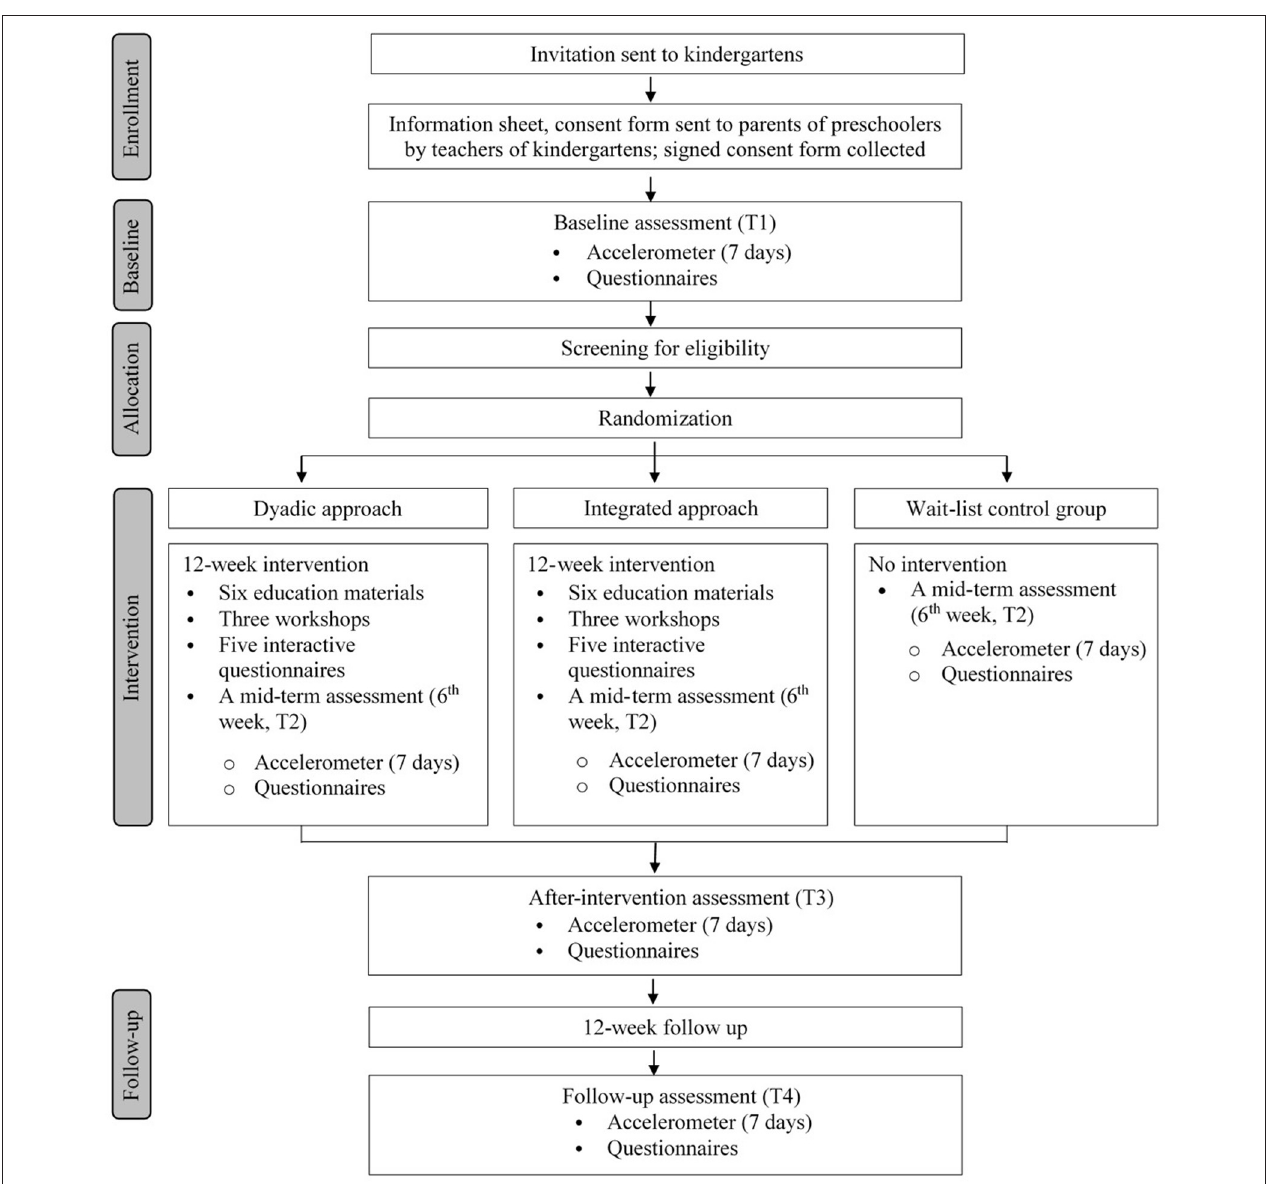
FIGURE 1 | Flow chart of the